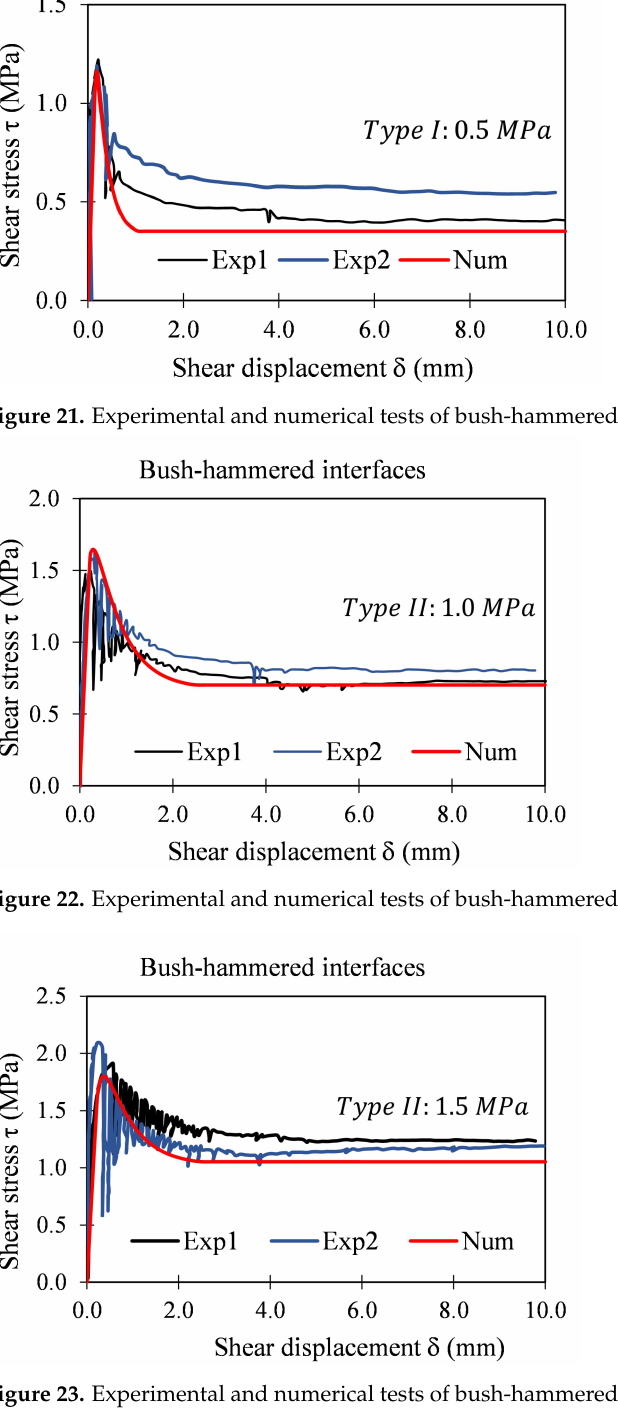
Figure 23. Experimental and numerical tests of bush-hammered interfaces